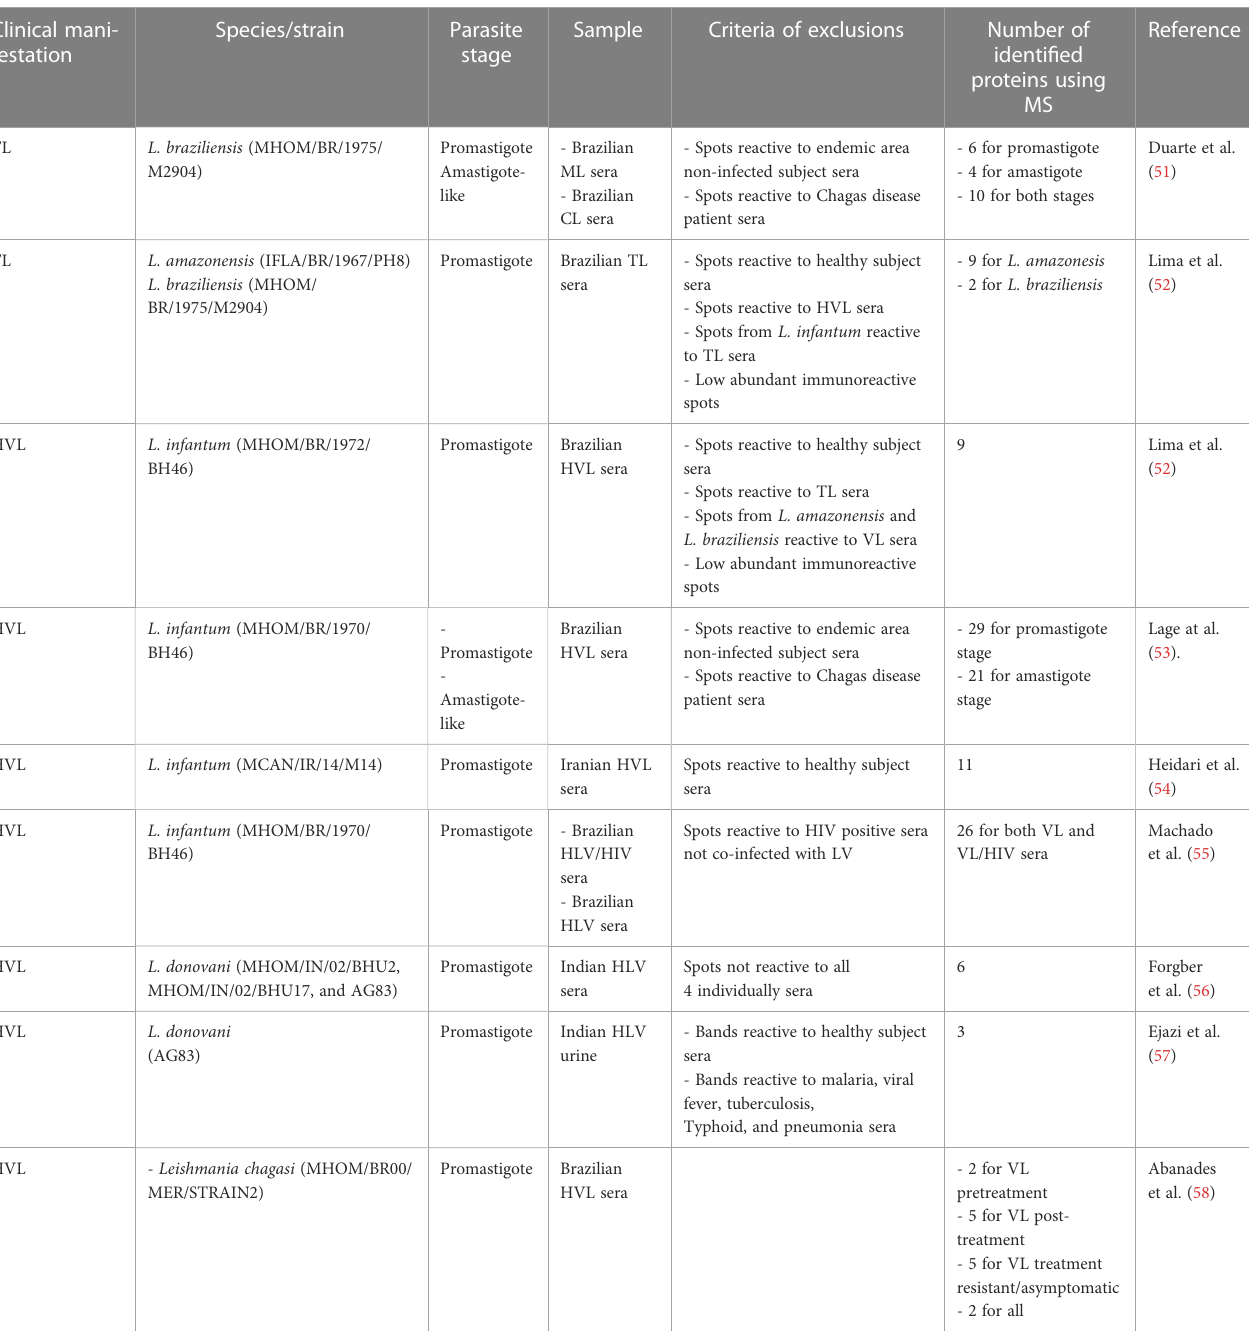
TABLE 1 Summary of Leishmania immunoproteomic